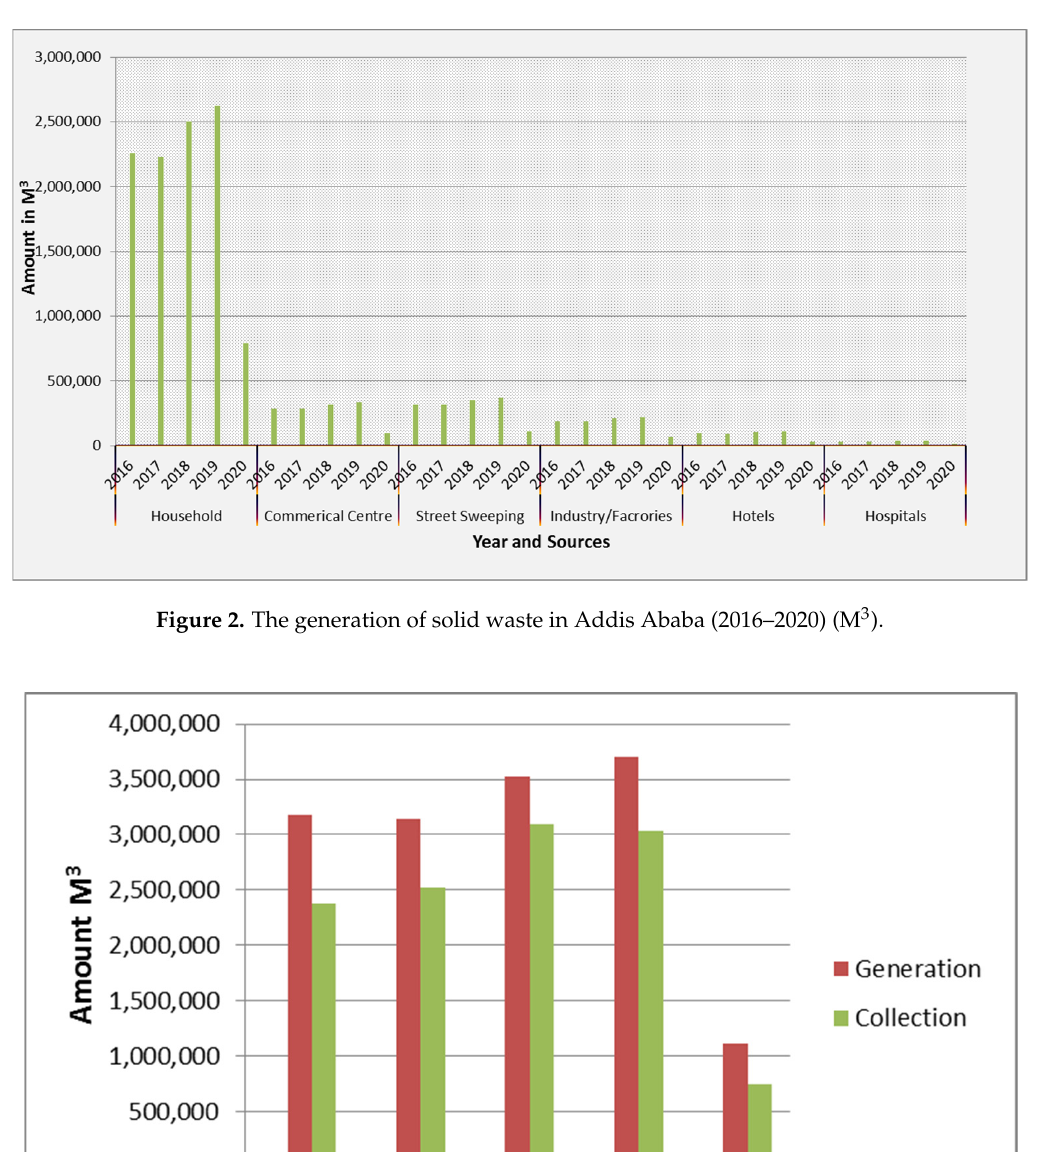
Figure 2. The generation of solid waste in Addis Ababa (2016–2020) (M 3 ).